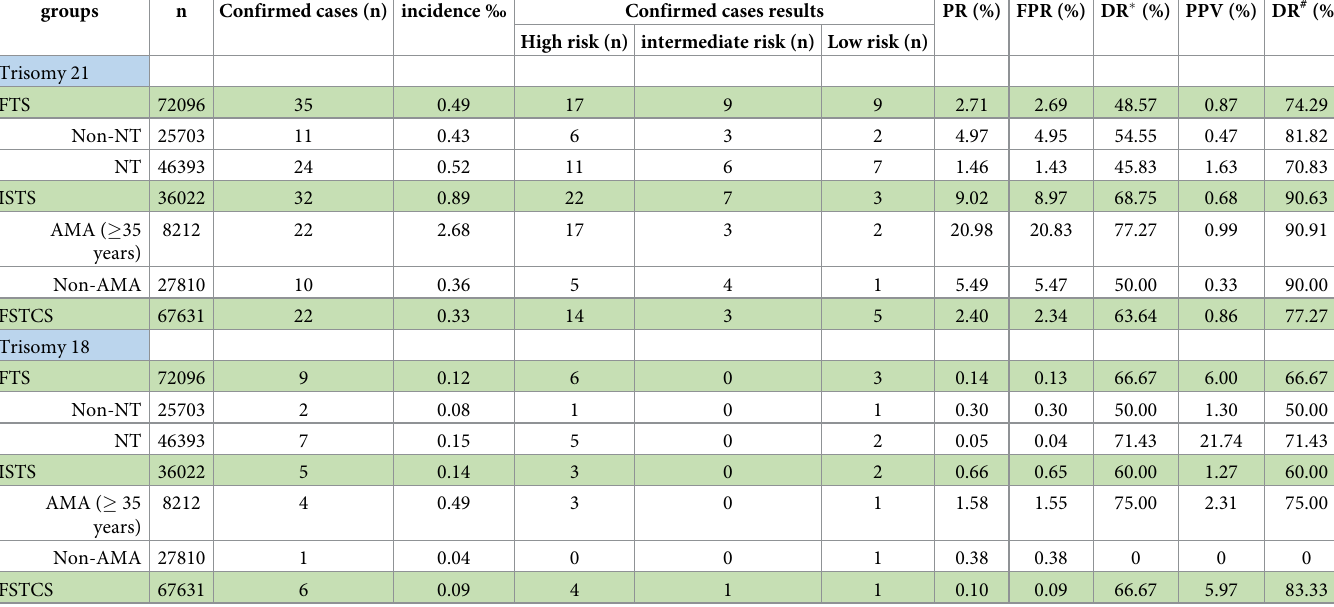
a FTS: first-trimester screening; ISTS: individual second-trimester screening; FSTCS: and first and second-trimester combined screening; NT: nuchal thickness; AMA: Advanced maternal age ( � 35 years); PR, positive rate; FPR, false positive rate; DR; detection rate without intermediate risk; PPV, positive predictive value; DR # detection rate with intermediate risk and high